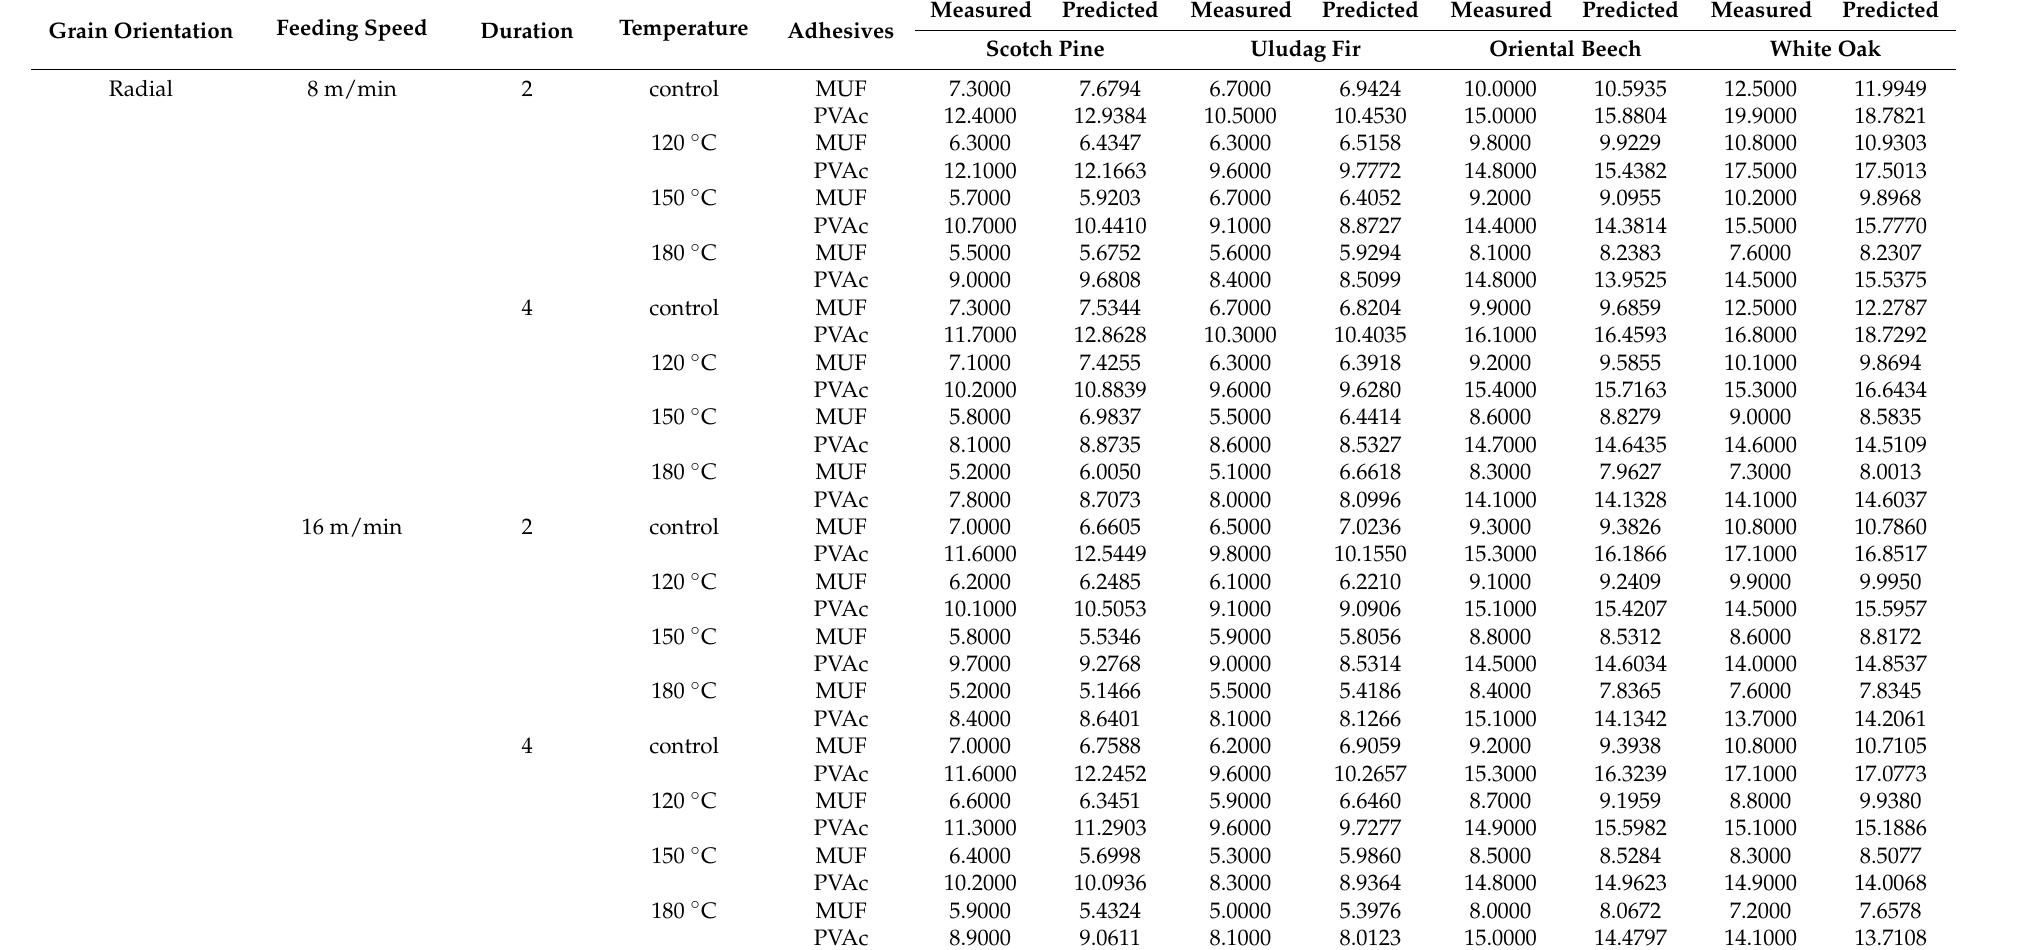
Table 5. The measured and the predicted values of bonding